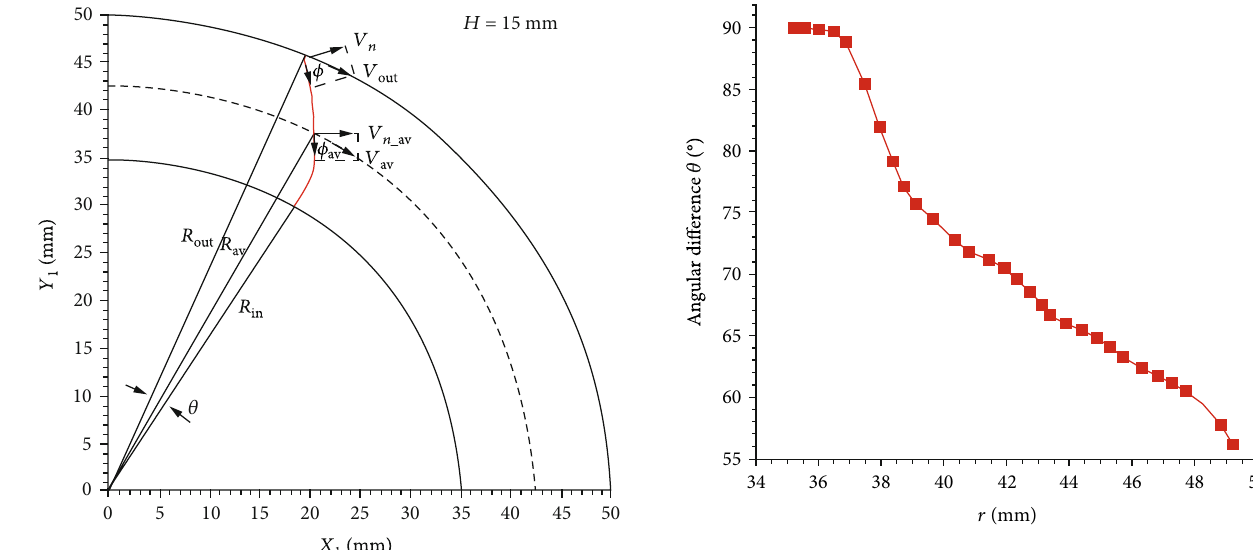
Figure 10: Variation of the angular di ff erence ϕ